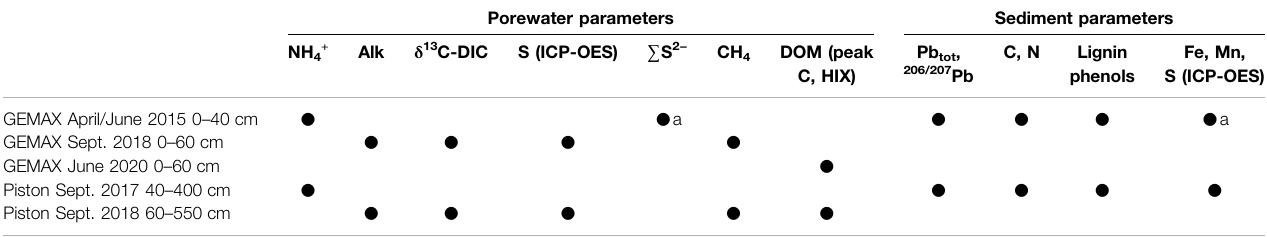
TABLE 1 | Sediment cores on which geochemical analyses of porewaters and sediments were performed, along with depth intervals presented in this study. For GEMAX cores from 2015, sediment parameters derive from the April core, while porewater parameters derive from the June